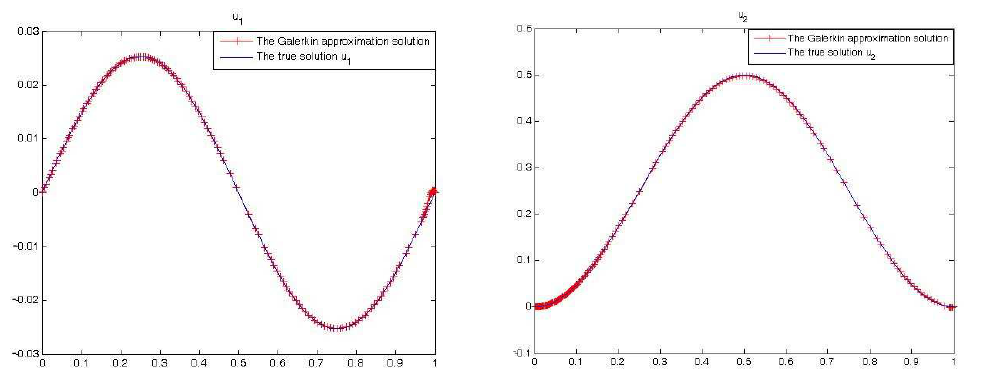
Figure 2. The figure of the Galerkin approximation solution ( j = 6) and the exact solution u 1 ( left ), u 2 ( right